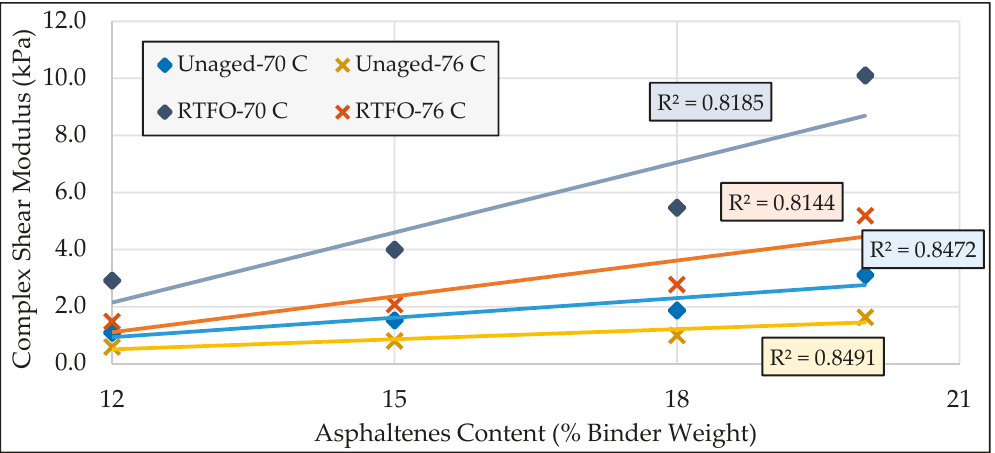
Figure 3. Comparison of rheological properties of the first group of modified binders: ( a ) complex shear modulus; ( b ) phase angle; ( c ) rutting factor.